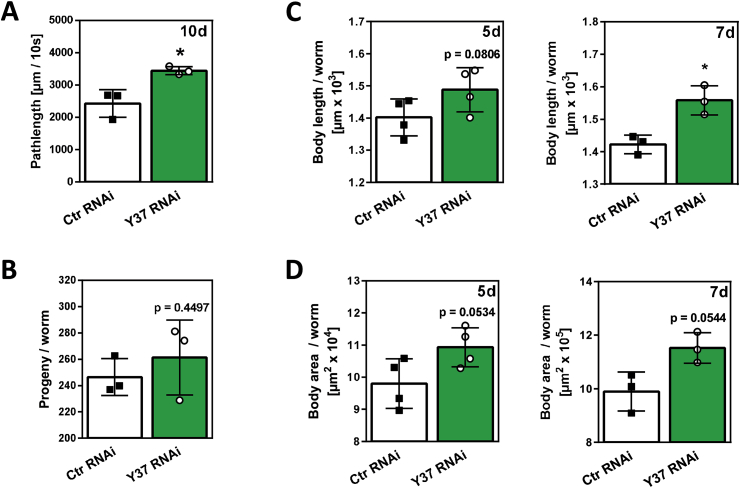
Y37A1B.5 downregulation improves C. elegans health parameters. (A) Motility of worms after 10 days of RNAi treatment (Y37A1B.5 RNAi vs. control); movements of individual worms were captured by a camera and distances covered per 10 s calculated using a tracking software. For an individual experiment, 10 worms were analyzed per group; three independent experiments were performed (*p<0.05, paired t-test). (B) Progeny per worm depleted of Y37A1B.5 through RNAi. 64 h after synchronization worms were transferred to RNAi plates. Each day, single worms were transferred to a new agar plate until nematodes ceased to lay eggs. Worms were allowed to hatch from the eggs and to grow until reaching the L3 larval stage before being counted. The experiment was conducted in quintuplicates and performed three independent times (p>0.05 vs. control; paired t-test). (C) Body length [μm] per worm (*p<0.05, paired t-test) and (D) body area [μm2] per worm after Y37A1B.5 RNAi. Young adult worms were exposed to control or Y37A1B.5-specific RNAi for 5 or 7 days. Pictures were taken and worms were measured using NIS elements software (Nikon). 10 worms were analyzed for each treatment group, and the experiment was repeated twice (7d) or three times (5d). Data shown are means ± SD (statistical analysis: paired t-test).